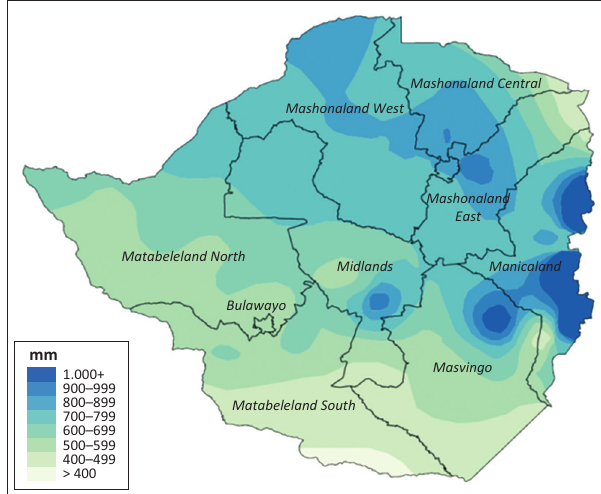
FIGURE 1 : Southern Africa: Timeline of El Niño humanitarian impacts.